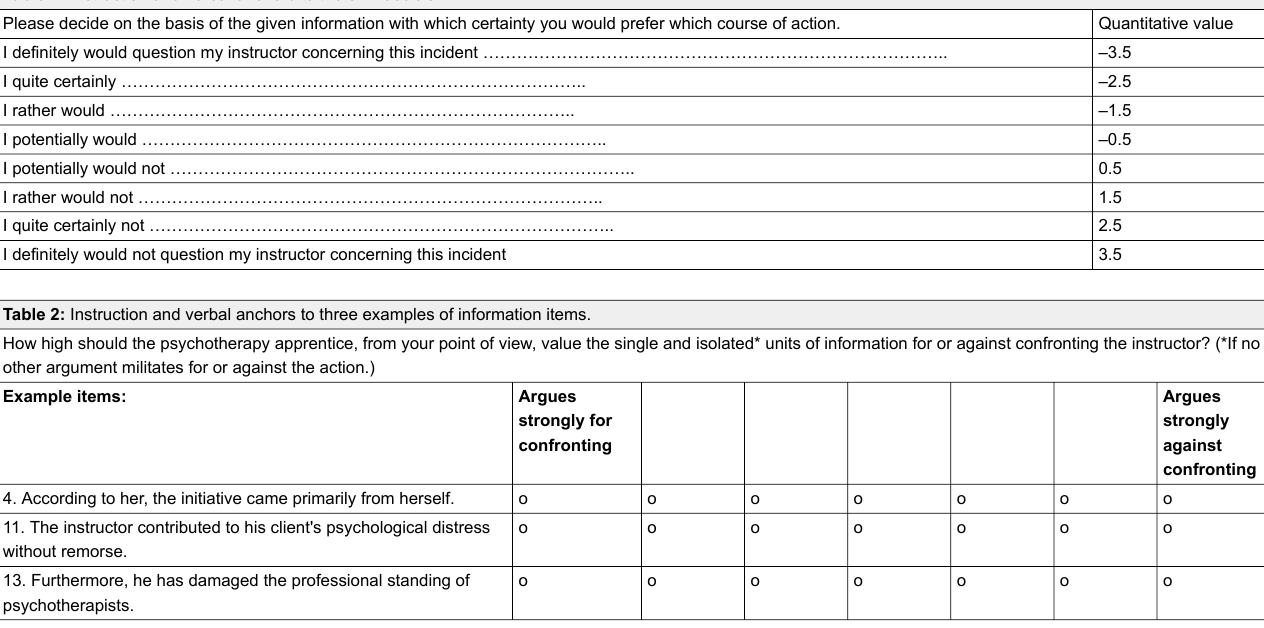
Table 3: Instruction and verbal anchors to the prescriptive statement. Please decide on the basis of the given information which course of action the psychotherapy apprentice should choose and with which certainty. Quantitative